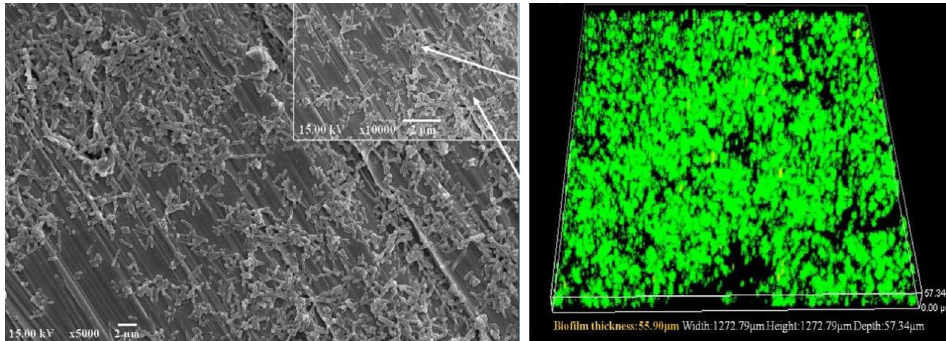
Fig. 6 SEM (left) and CLSM (right) images of A. caldus SM-1 biofilm on S32654 SASS steel coupon surface [Dong et al.